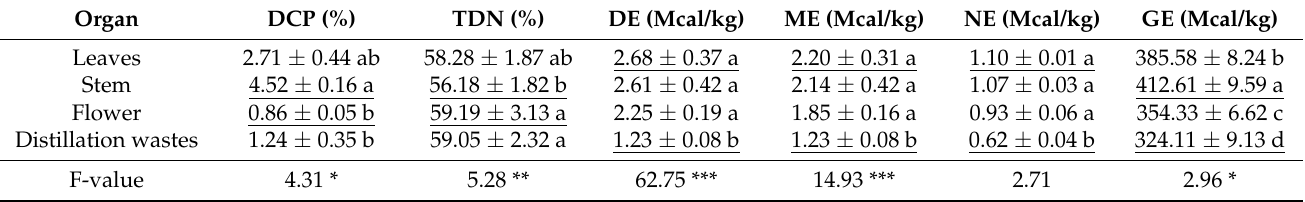
Table 4. Nutritional value (mean ± SD, n = 12) of the different organs of Taif’s rose grown on Al-Shafa highlands in Taif City, Saudi Arabia. Maximum and minimum values are